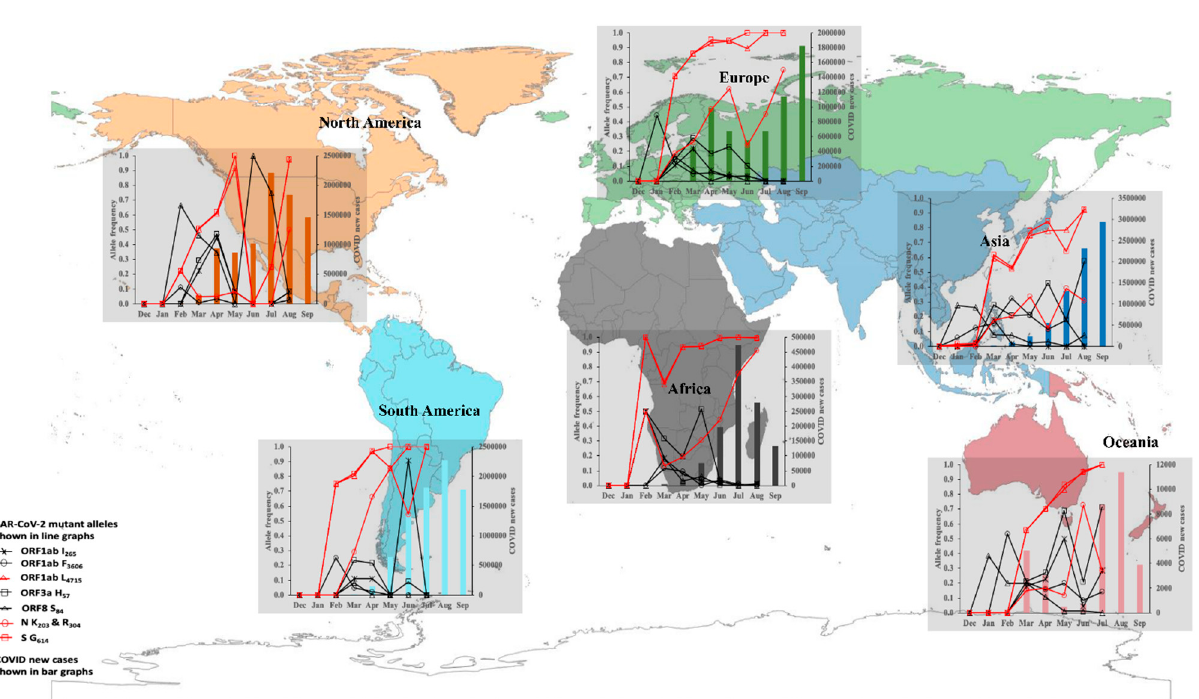
Figure 1. Longitudinal prevalence of eight SARS-CoV-2 mutant alleles and reported new cases of COVID-19 in 2020. The prevalence data for the alleles and newly confirmed cases (WHO report 2020) are reported for December 2019 to September 2020. The frequency of the eight mutant alleles is shown with the line graph. Four mutant alleles, orf1ab L 4715 , S G 614 , and N K 203, and R 204 , were associated with sharp peaks in the number of COVID-19 new cases (bar graph).